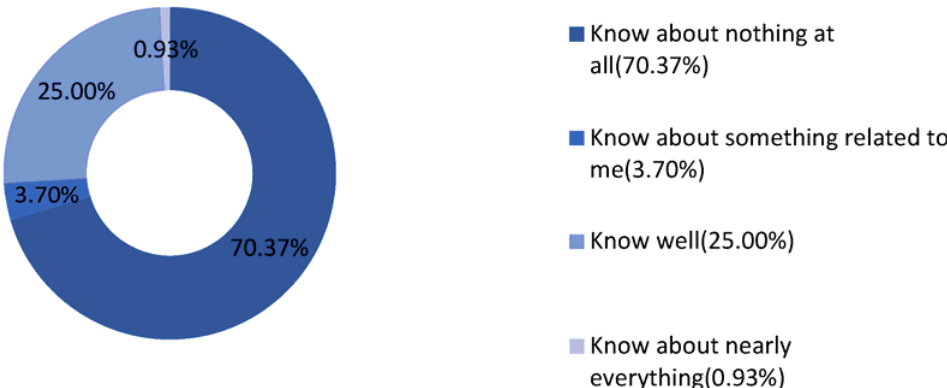
Figure 3. Villagers’ understanding of Lingquan Village planning. The original question was “Do you know about the planning and design of Lingquan Village?”.